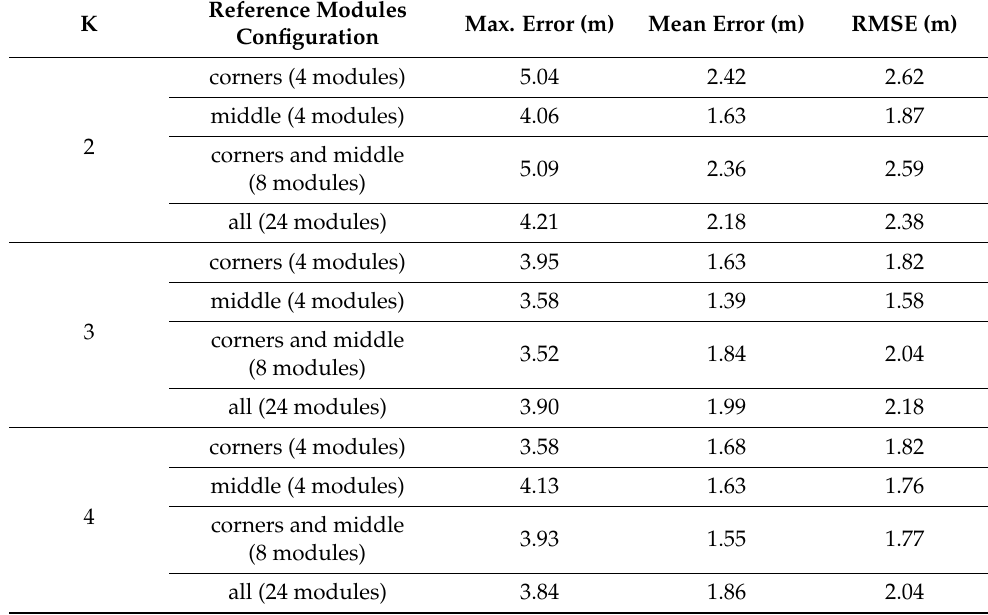
Table 4. The overall estimation accuracy results (maximum error, mean value, and RMSE) calculated with received signal strength (RSS) normalization introduced in the proposed localization algorithm. K